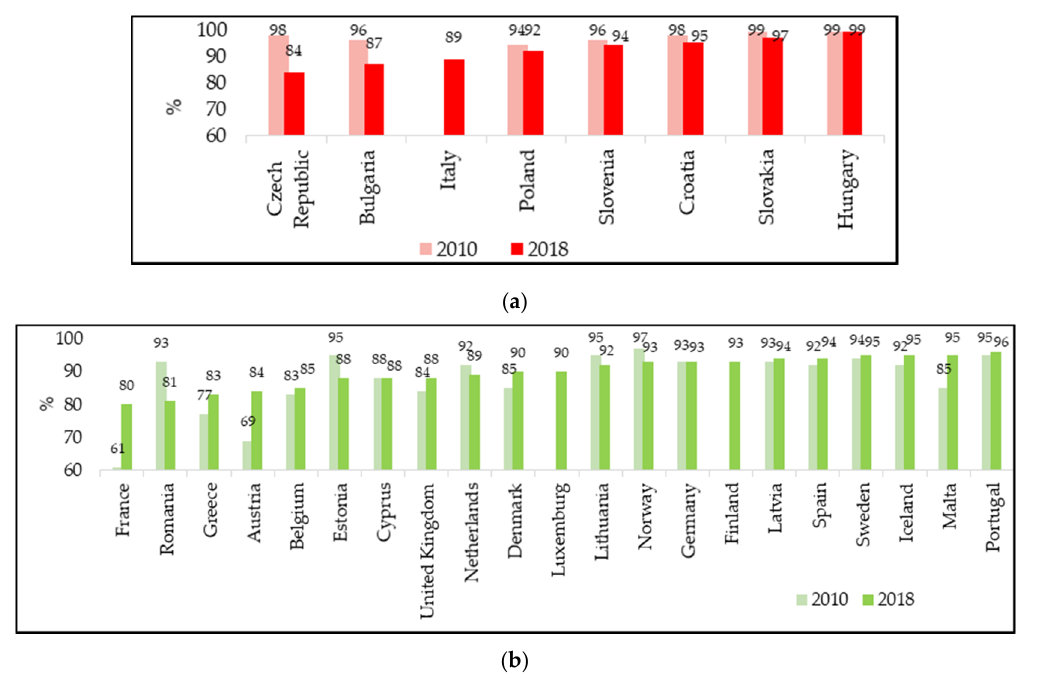
Figure 3. Vaccination coverage for the second dose of measles-containing vaccine in 2010 and 2018: ( a ) Countries with mandatory vaccination.Italy is listed among the countries with mandatory vaccination due to its recent change in vaccination policies in 2017. Vaccination coverage for the second dose of measles-containing vaccine in 2010 for Italy is not available; ( b ) countries with recommended vaccination (WHO/UNICEF reports). France is included in the recommended vaccination countries because vaccination, made mandatory for children born from 2018, has not yet been performed in the 2018 cohort.